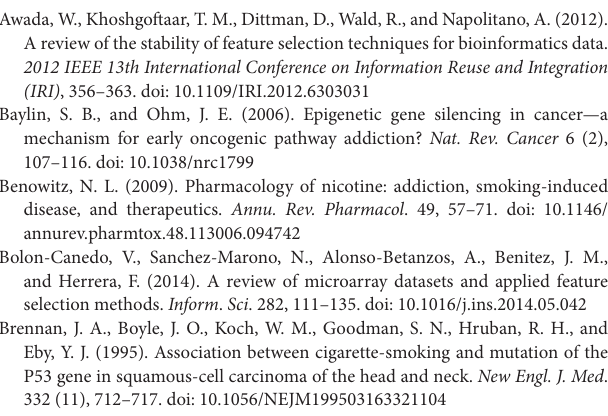
FIGURE S1 | (A) The distribution density of DML in 22 pairs of autosomal chromosomes in 13 cancers. (B) The distribution of DML in different functional regions in 13 cancers. (C) The distribution of DML in CpG island and non-CpG island in 13 cancers. FIGURE S2 | Unsupervised hierarchical clustering of mutual DML in 13 cancers using similarity measure with Jaccard distance. FIGURE S3 | The AUC changed when the number of selected loci gradually reduced in each cancer. All the results show that HyDML performed better than single-feature selection methods as it can select more robust loci for distinguish normal and tumor samples. FIGURE S4 | The t-SNE clustering results with the loci that were uniquely selected by the three methods, HyDML, FastDMA, and RnBeads. Each row represents the loci from the corresponding cancer type, and each column represents the result of corresponding